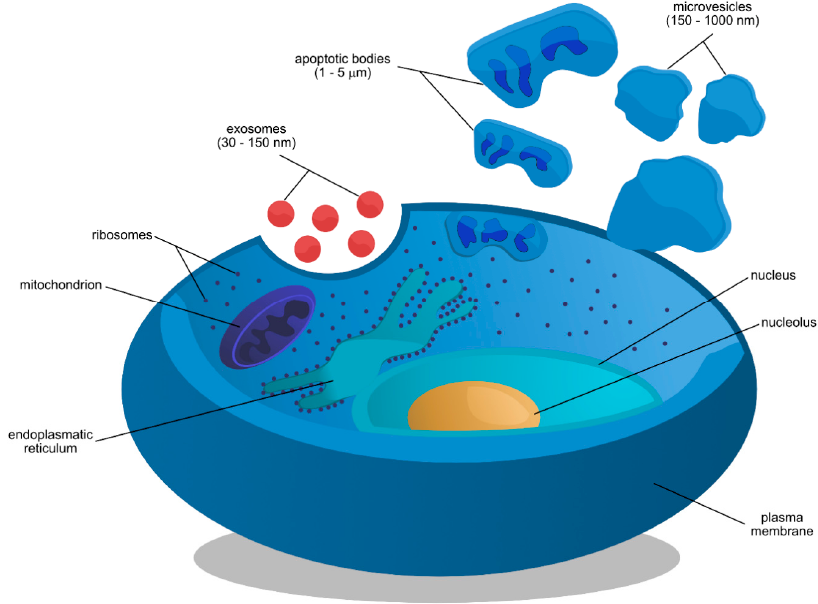
Figure 1. Biogenesis of three types of extracellular vesicles including exosomes, apoptotic bodies and microvesicles. All nanovesicles are released into the extracellular space, however their synthesis is dependent on the state of cell, e.g., apoptotic bodies are only produced during programmed cell death, while exosomes and microvesicles are secreted during cell cycle and normal state of cell.